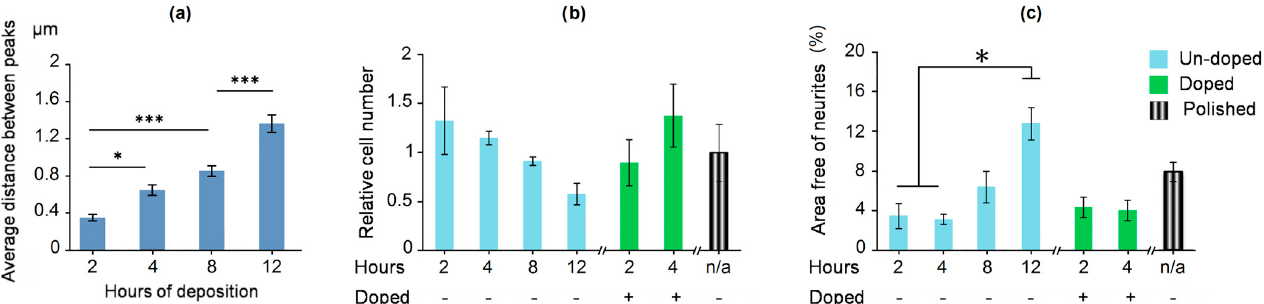
Figure 6. Neural growth in function of diamond surface morphology: ( a ) average distance between sharp peaks on two adjacent crystallites; values represent the average of 20 distances on 4 microscopic fields from 2 samples. ( b ) Number of cell nuclei present on each type of substrate, compared in function of the number of cells growing on the control substrate (polished non-doped diamond) that has been normalised to 1. ( c ) Percentage of area (mean ± s.d., n = 3) devoid of neurites for each type of substrate. * p < 0.05, *** p < 0.001. Adapted from Nistor et al . [40] under a Creative Commons